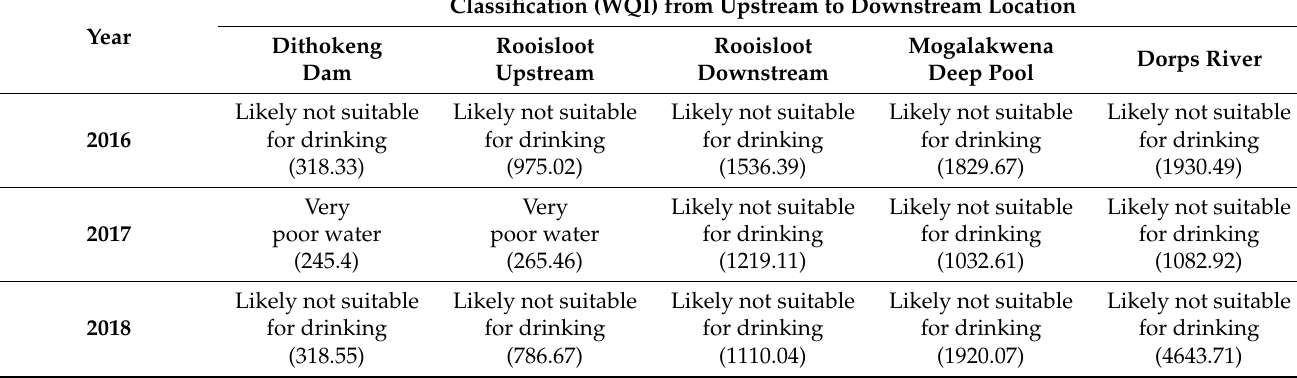
Table 7. Water quality index (WQI) results for the period